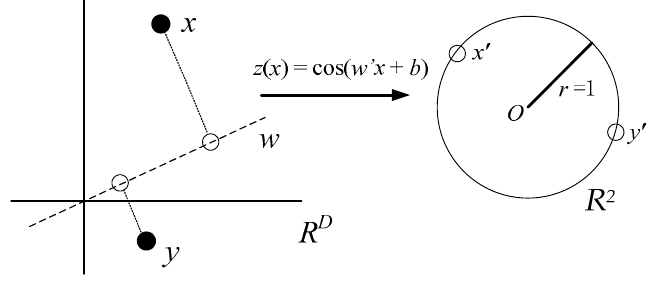
Figure 2. Random Fourier Feature map.